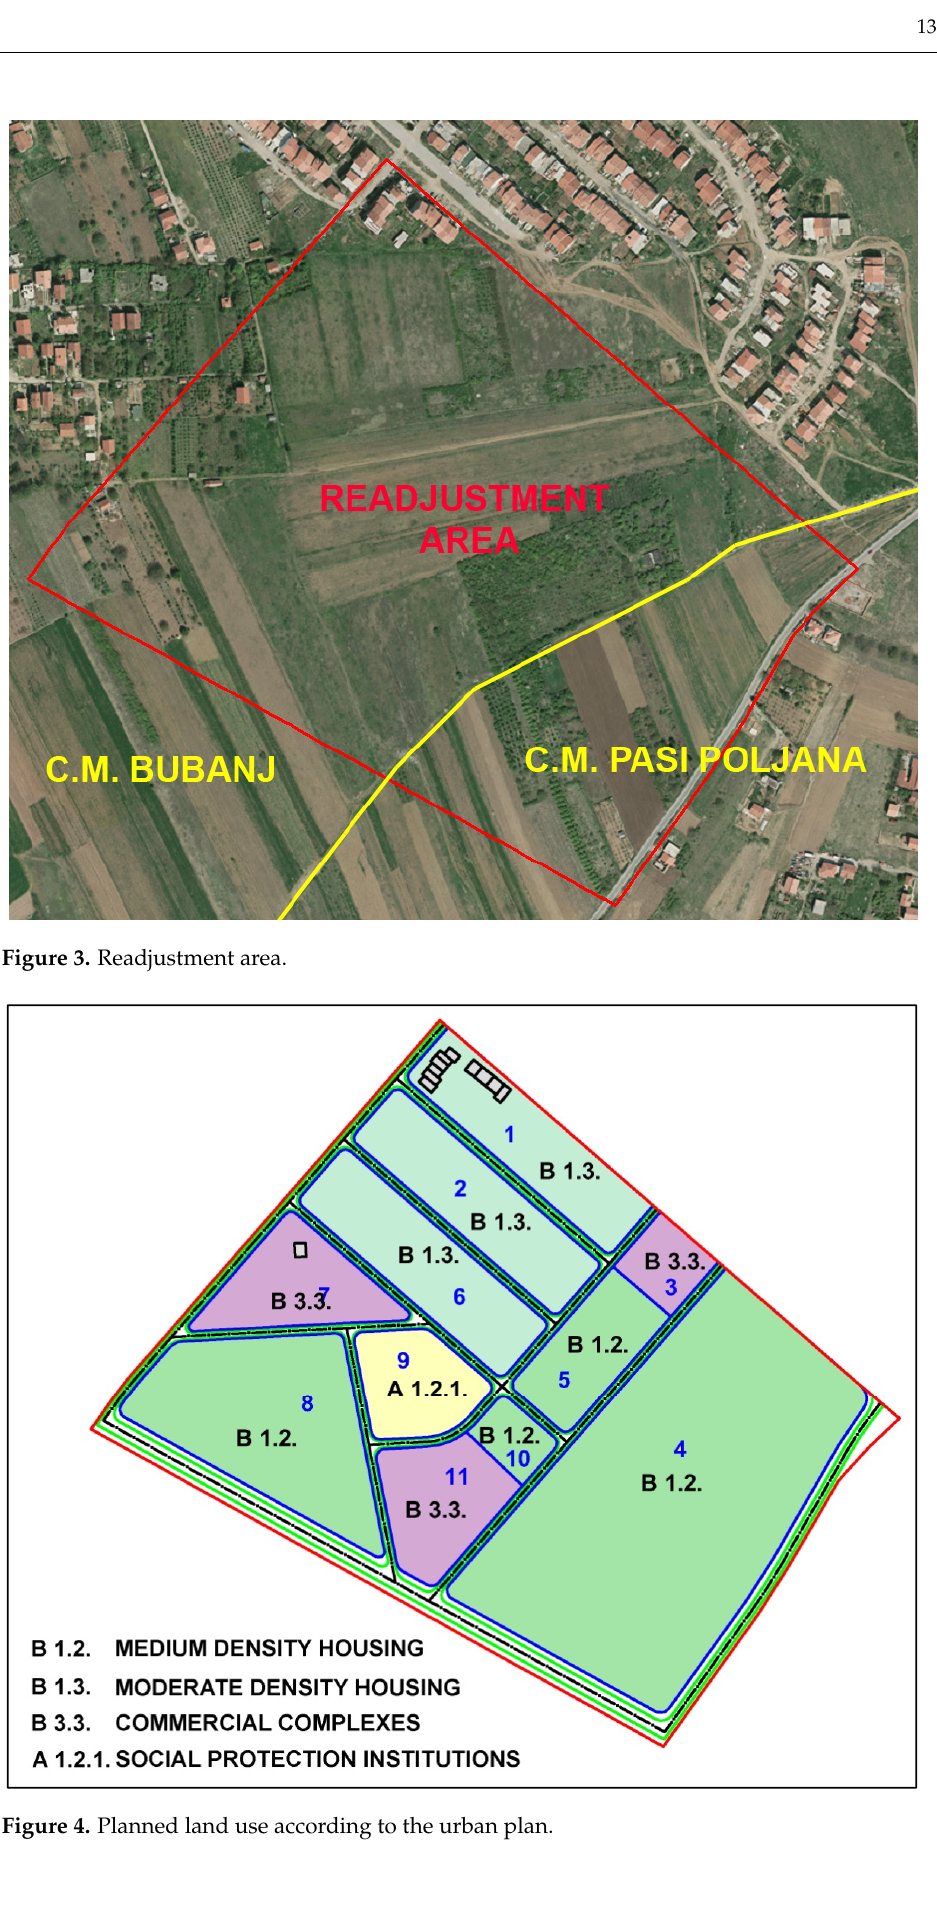
Figure 4. Planned land use according to the urban plan.